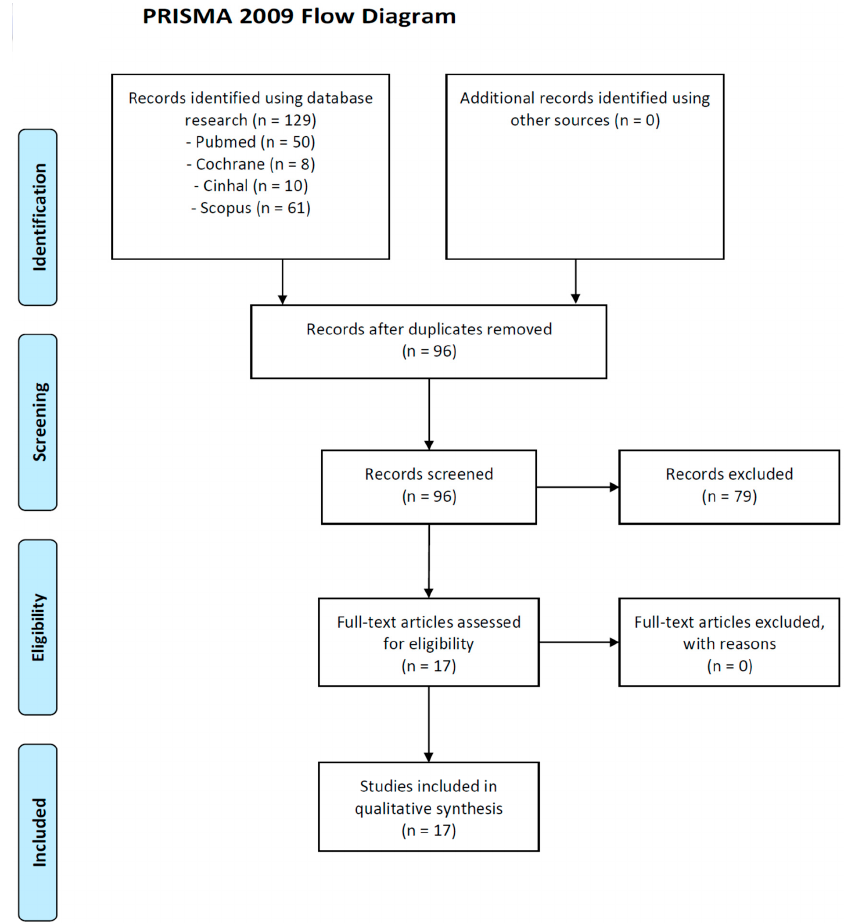
Figure 1. PRISMA 2009 Flow Diagram [37]